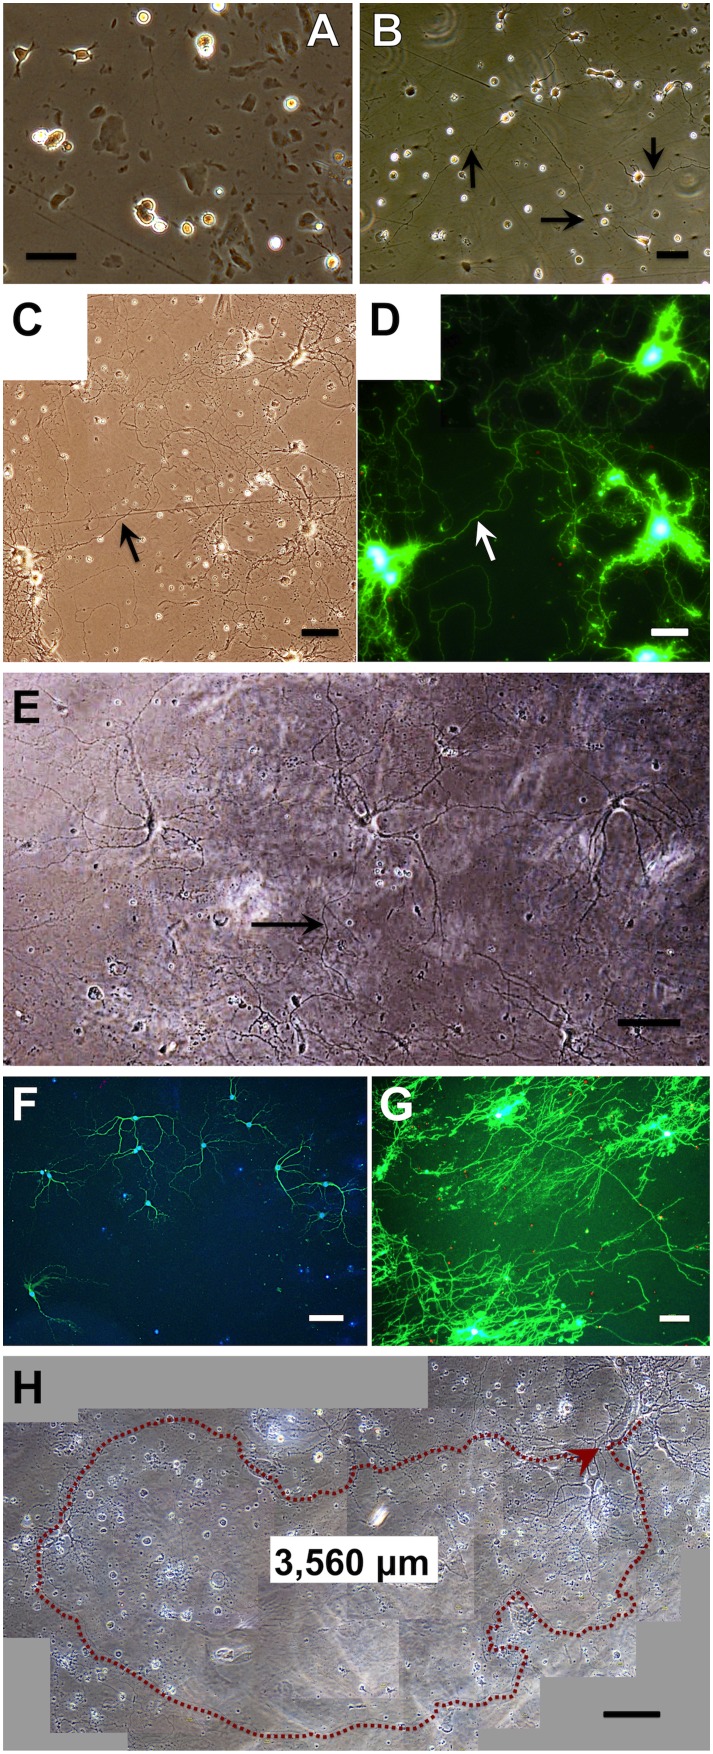
Developmental pattern of primary neurons plated on 25% PuraMatrix at 3×104 cells/mL.The neurons were isolated from the hippocampi of embryonic rats (E18) and cultured in basic medium #0 or #2 (E, H). A coverslip was placed over the neurons 3 h after plating. Bars: 50 µm or 100 µm (E–H). (A) Phase-contrast image of neurons 3 h after plating. The neurons attached to PuraMatrix, and extended lamellae or short neurites within 50 µm. (B) Phase-contrast image of neurons at DIV 1. The neurons started to extend one neurite that was several times longer than the others. The long neurites (arrows, approximately 300 µm) are assumed to be axons, and the other, shorter ones, dendrites. (C) Phase-contrast image of neurons at DIV 21. The neurons extended neurites for several hundred microns (axons, arrow), as well as neurites with branches and spines (dendrites). Axons and dendrites formed fine networks. (D) Fluorescence image of (C), stained with the LIVE/DEAD Viability/Cytotoxicity Kit. Living cells and neurites are stained green, dead cells red. (E) Phase-contrast image of neurons at DIV 36. The neuronal cell bodies are increased in size. Dendrites have characteristic spines that are increased in length, tapered and branched. Axons (arrow) show a uniform diameter over a long distance. The neurons formed neuronal networks and matured. (F) Fluorescence image of neurons at DIV 38. Neurons and astrocytes are double-stained with anti-MAP2 for neurons (green) and anti-GFAP for astrocytes (red), with DAPI as a nuclear counterstain (blue). Neuronal survival for 5 weeks without glial proliferation is shown. (G) Fluorescence image of neurons at DIV 42, stained with the LIVE/DEAD Viability/Cytotoxicity Kit. Neuronal survival and neurite extension is shown. (H) Phase-contrast image of neurons at DIV 63. The neurons show bright, round, and smooth somas, and long axons of a uniform diameter (3,560 µm, arrow), suggesting their survival for 2 months.